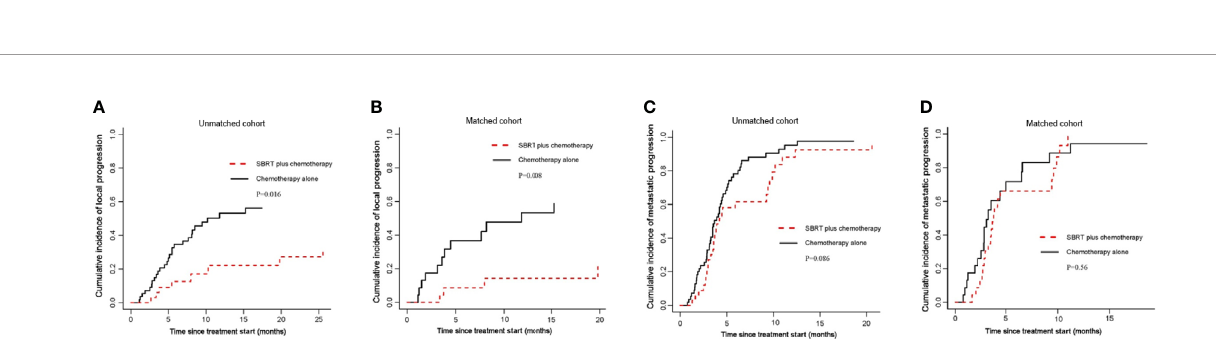
FIGURE 3 | Cumulative incidence curves for the probability of each competing event. (A) cumulative incidence of local progression in the unmatched group; (B) cumulative incidence of local progression in the matched group; (C) cumulative incidence of metastatic progression in the unmatched group; (D) cumulative incidence of metastatic progression in the matched